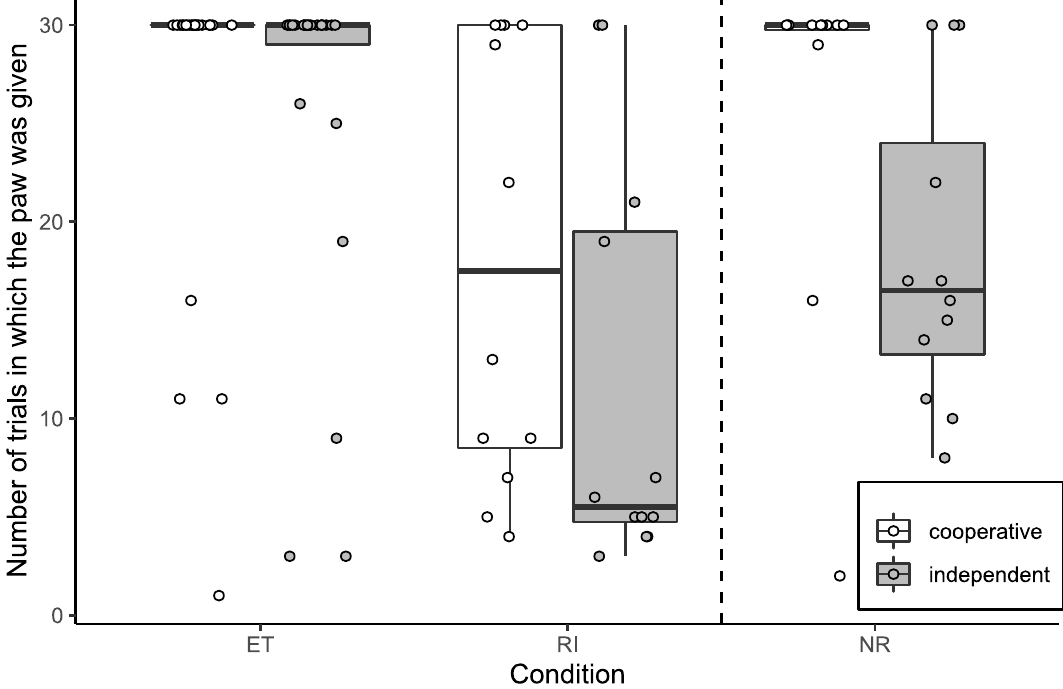
Fig 2. Number of times the paw was given on command by cooperative worker (N = 12) and independent worker (N = 12) breeds in each condition of the paw task. Boxes display the interquartile range, black horizontal bars represent the median, whiskers represent the range of data points within 1.5 times the interquartile range from the upper and lower hinge, and circles represent individual data points; dashed, vertical line separates social and asocial conditions. ET, equity; RI, reward inequity; NR, no-reward.